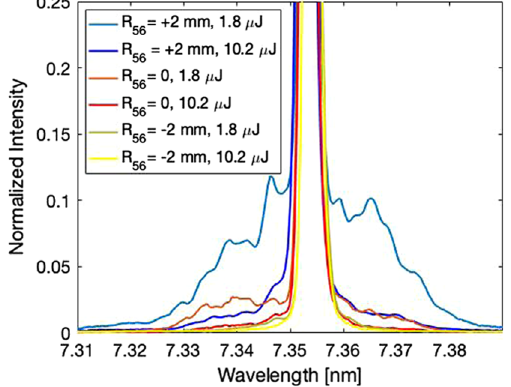
FIG. 4. EEHG spectrum (average over 31 shots) for the three spreader optics in Fig. 1, at two laser heater pulse energies.